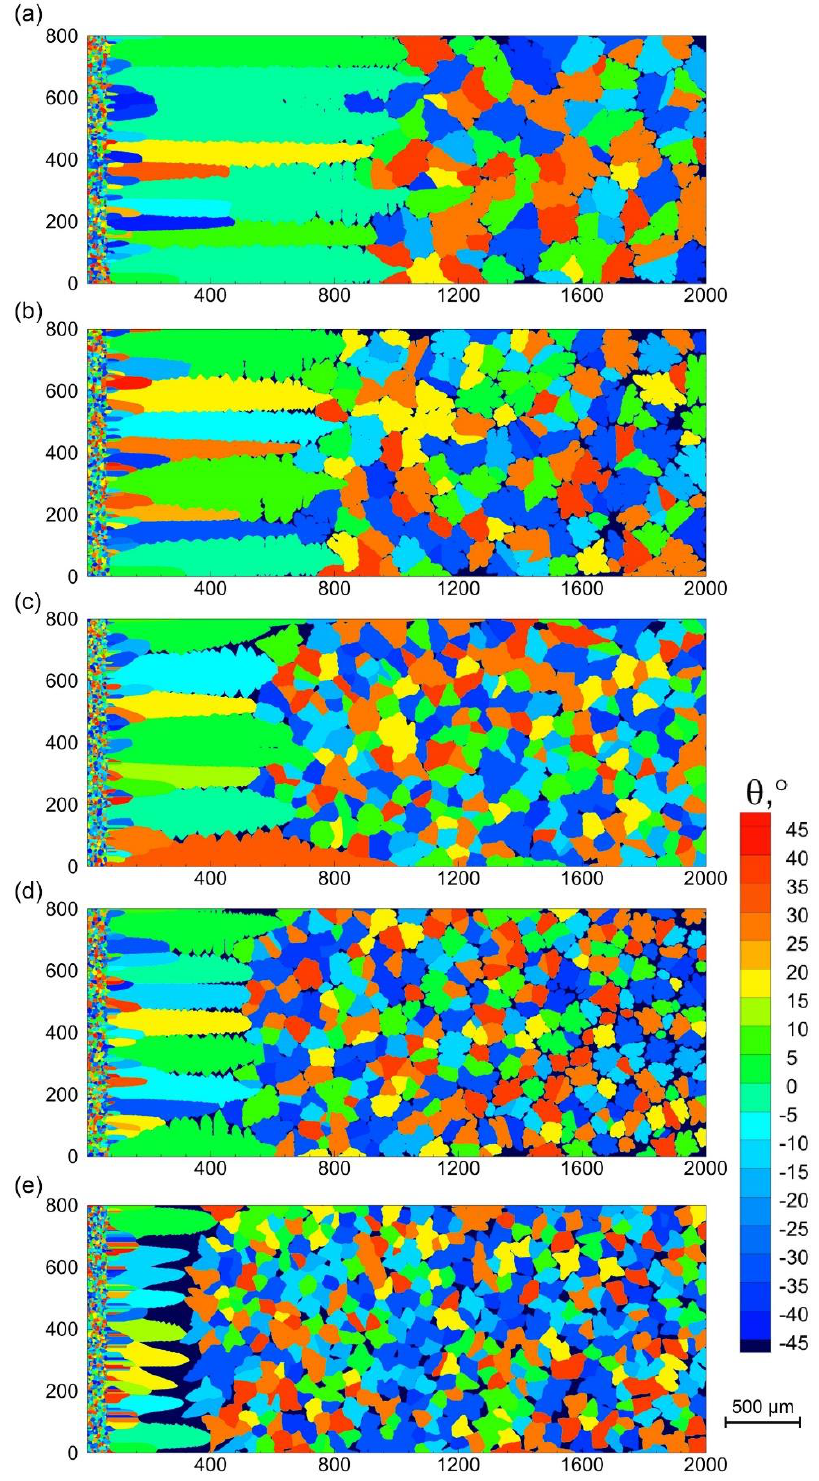
Figure 10. Simulated the dendritic structures formed in the melt under different vibration frequencies of the crystal nucleus generator. The vibration frequency is 500, 800, 1000, 1500, 1800 Hz from ( a )−( e ), respectively. Different colors represent grains with different crystallographic orientations.